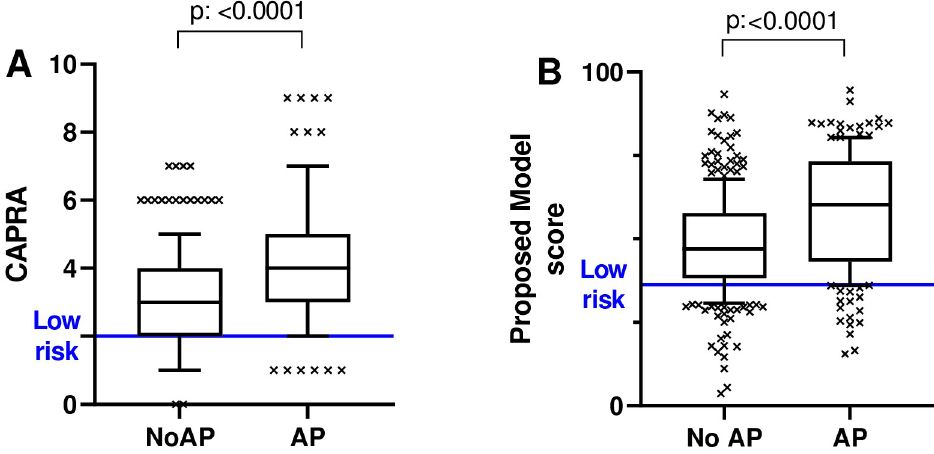
Fig 2. Association with adverse pathology (AP) features. (A) CAPRA and (B) proposed model.